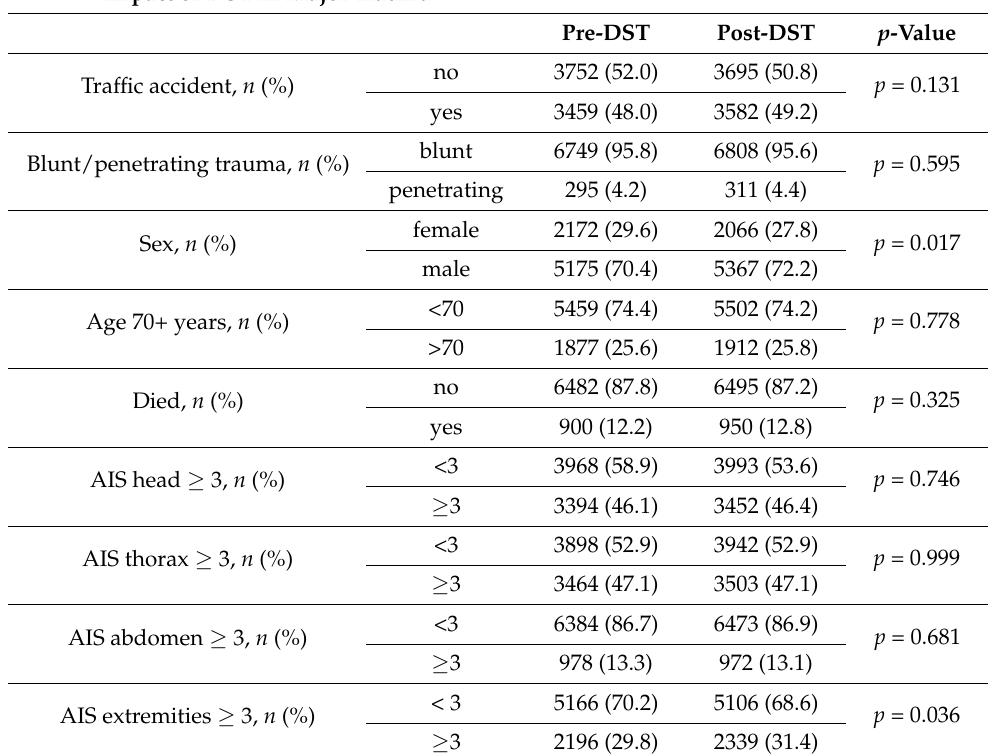
Table 2. Cross tabulation.